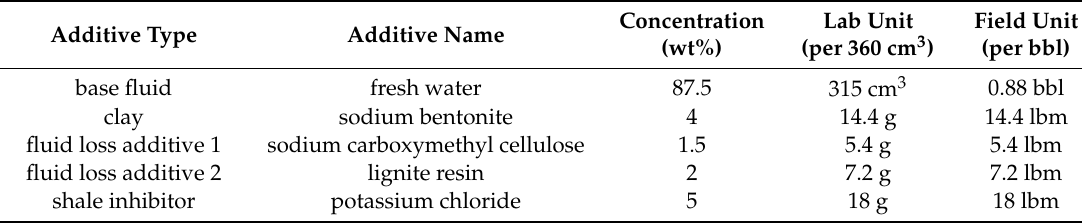
Table 3. Composition of the water-based drilling